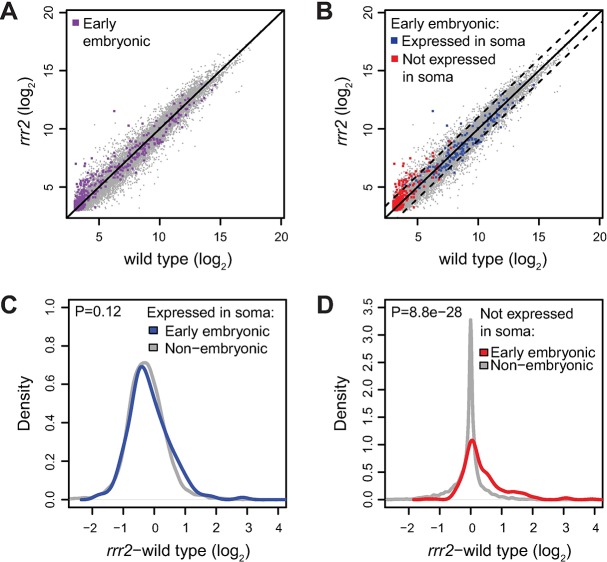
Embryonic genes are globally induced in mutant animals.(A) Scatter plot comparing transcript abundance in wild type (x-axis) and rrr2 animals (y-axis). Colored in purple: Early embryonic transcripts (selected as described in Materials and Methods). (B) The plot as in A. Colored in blue: early embryonic transcripts expressed in the soma. Colored in red: early embryonic transcripts not expressed in the soma. Somatic expression was determined from RNA-seq in glp-4 mutants (Material and Methods). Dashed lines indicate 2-fold changes. (C) Density plots depicting expression changes in rrr2, compared to wild type, for early embryonic (blue) and non-embryonic (grey) transcripts expressed in the soma. No difference between the two populations of transcripts could be detected (P = 0.12, p-value calculated with 2-sample Wilcoxon test). (D) Same as C, but considering only transcripts not expressed in the soma, with early embryonic transcripts colored in red. In this case, the population of early embryonic transcripts showed a positive shift (P = 8.8 x 10−28, p-value calculated with 2-sample Wilcoxon test), indicating their upregulation in the mutant.